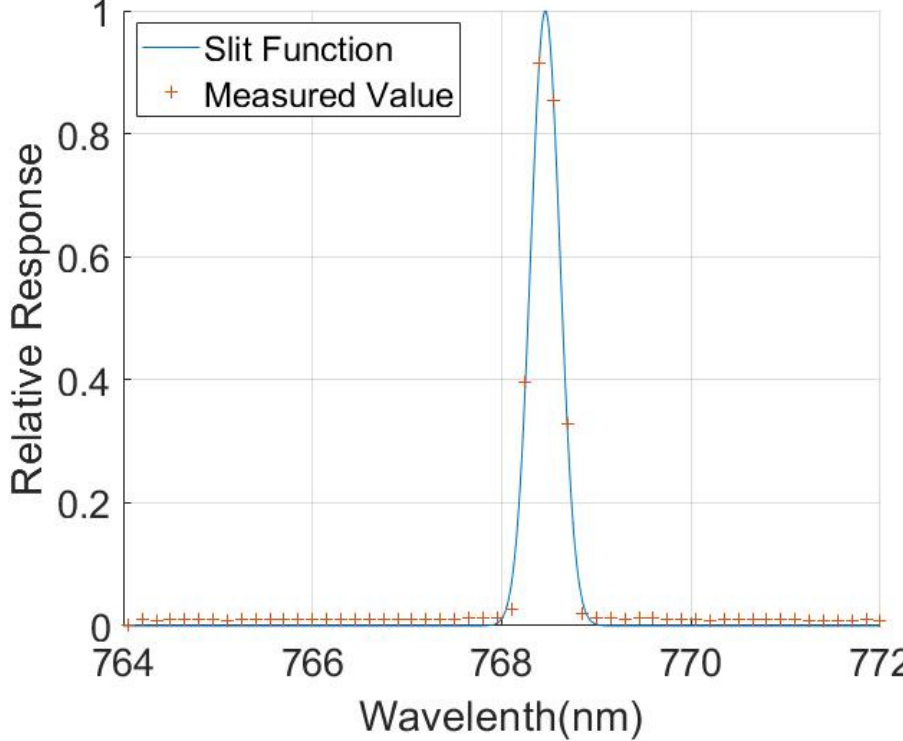
Figure 5. Slit function of the 150th pixel in the 120th row, which corresponds to the central wavelength at 768.46 nm and a FWHM of 0.36 nm.